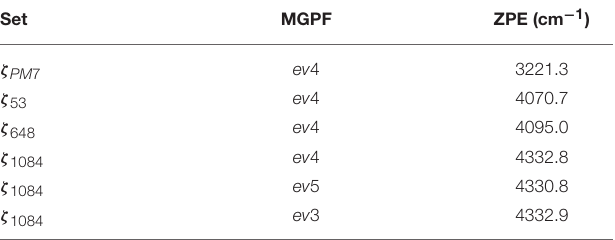
The first column indicates the set of SRP parameters used, labeled by its set of parameters, ζ N , where N is the number of points used in the fit (see Table 1 ). The second column presents the size of the MGPF coarse grid: evn indicates a coarse grid in which every (ev) n-th fine grid point has been considered (see section 3.2.1). The final column presents the Zero Point Energies (ZPE) for each of the previous PES.